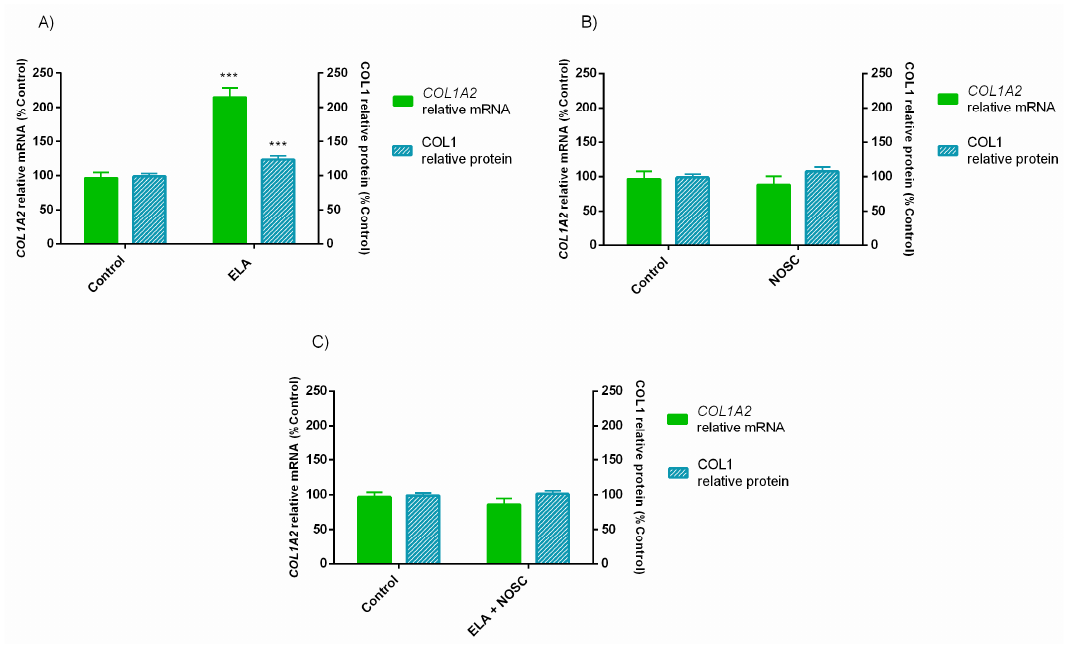
Figure 3. Effect of elastase (ELA; 0.5 and 1 µg/mL) ( A ), noscapine (NOSC; 45 µg/mL) ( B ) and ELA (0.5 and 1 µg/mL) + NOSC (45 µg/mL) ( C ) on relative collagen type I alpha 2 chain ( COL1A2 ) mRNA transcription and collagen type I (COL1) protein relative abundance in mare endometrial explants. The results are independent of ELA concentration, estrous cycle phase and treatment time. Results are displayed as least square means ± SEM, and considered significant at p < 0.05. Asterisks represent significant differences relative to the respective control (*** p < 0.001).